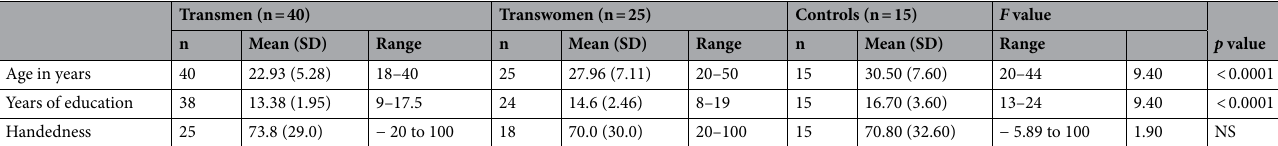
Table 1. Demographics. Handedness has been assessed according to Oldfield 42 . F-values from group comparisons (one-way ANOVA). Transmen were significantly younger than both transwomen and cisgender controls. Both transmen and transwomen had fewer years of education than cisgender controls. No difference in handedness were found. NS-not